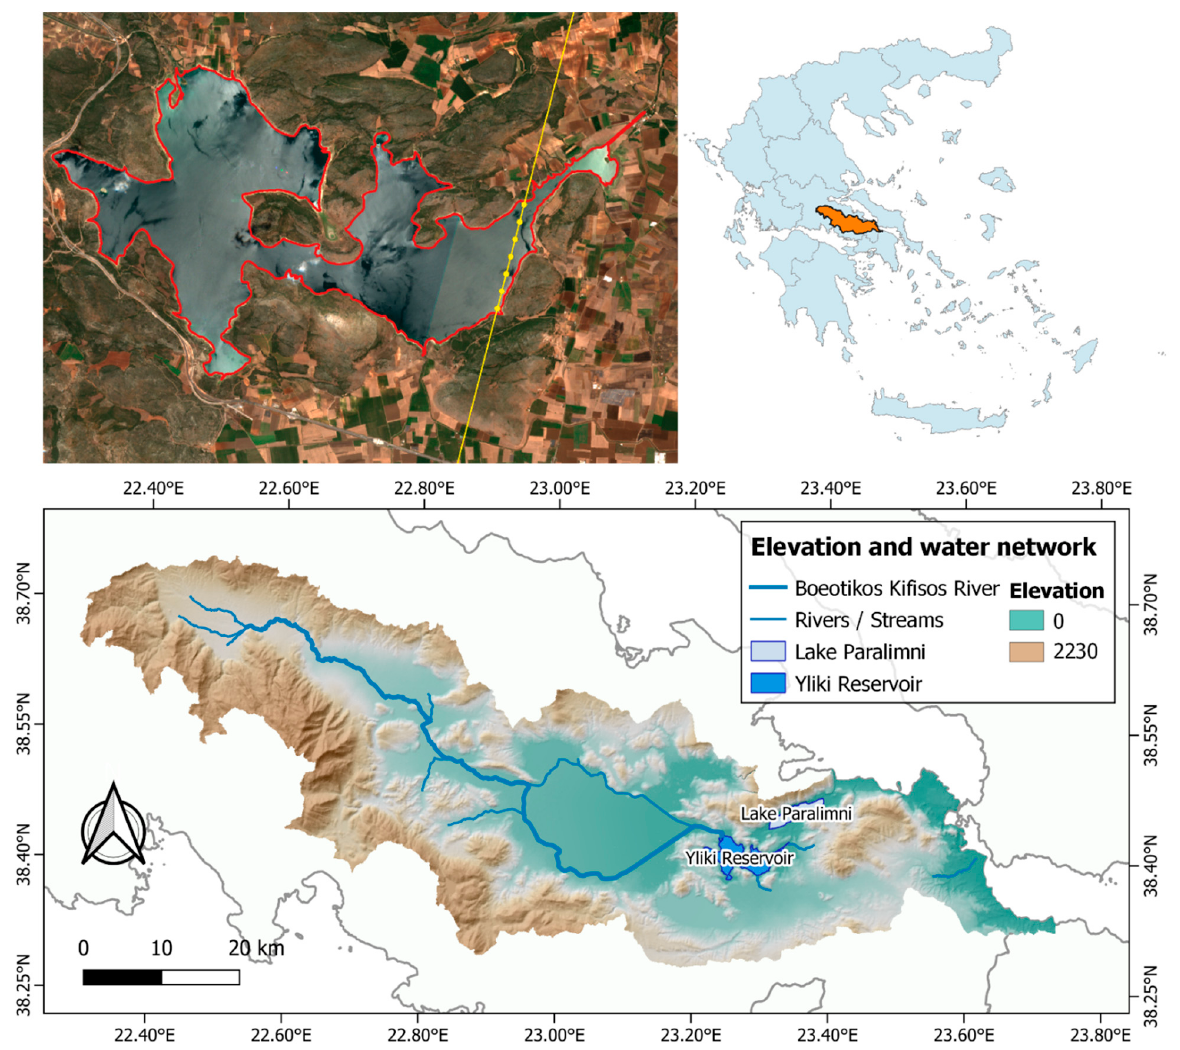
Figure 1. ( Upper left ): Yliki reservoir; true color image from Sentinel-2, captured on 13 July 2018. Red line: reservoir’s water perimeter derived from the applied methodology; yellow dots: SRAL point measurements from Sentinel-3 on 13 July 2018; yellow line: relative Sentinel-3 path, 10th cycle, 221th relative orbit. ( Upper right ): Boeotikos Kifissos River Basin District (EL0723) location over Greece. ( Lower ): Boeotikos Kifissos River Basin District river network, Yliki reservoir, and Lake Paralimni with a digital elevation model background.